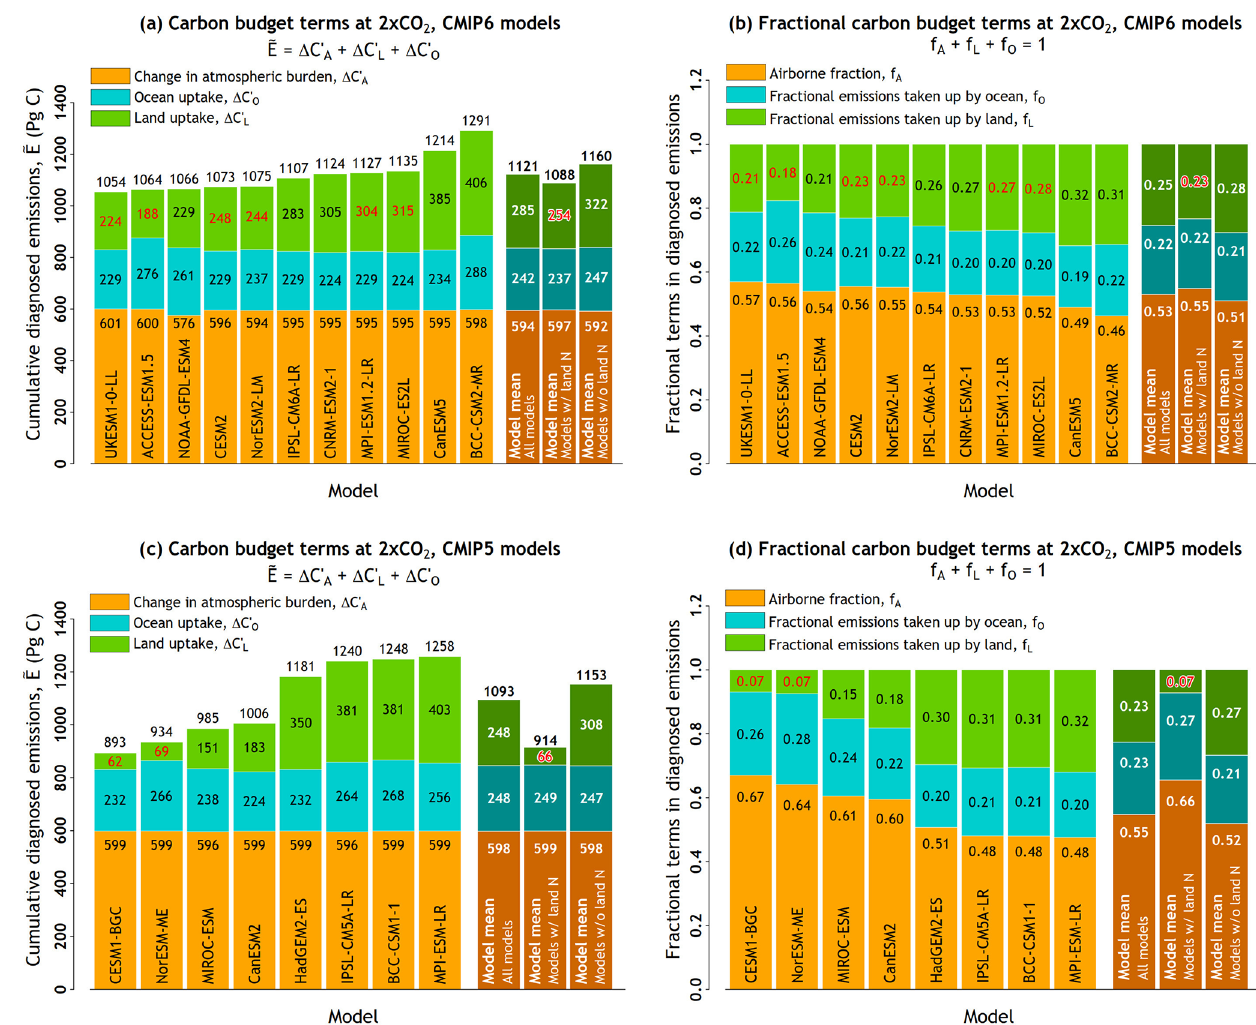
Figure A2. Components of the carbon budget terms in cumulative emissions from the 11 participating CMIP6 models based on Eq. (A6) in (a) and Eq. (A7) in (b) , using results from the fully coupled 1%yr − 1 increasing CO 2 simulation at 2 × CO 2 (year 70) in contrast to Fig. 4 which showed these results at 4 × CO 2 . The models are arranged in ascending order based on their cumulative emissions values. Results from participating CMIP5 models in the A13 study are shown in (c, d) . In addition, ESMs whose land component includes a representation of the N cycle are identified by a red font colour for cumulative land carbon uptake (a, c) and fractional emissions taken up by land (b, d) . The model mean is shown not only for all models but also separately for models whose land components include or do not include a representation of the N